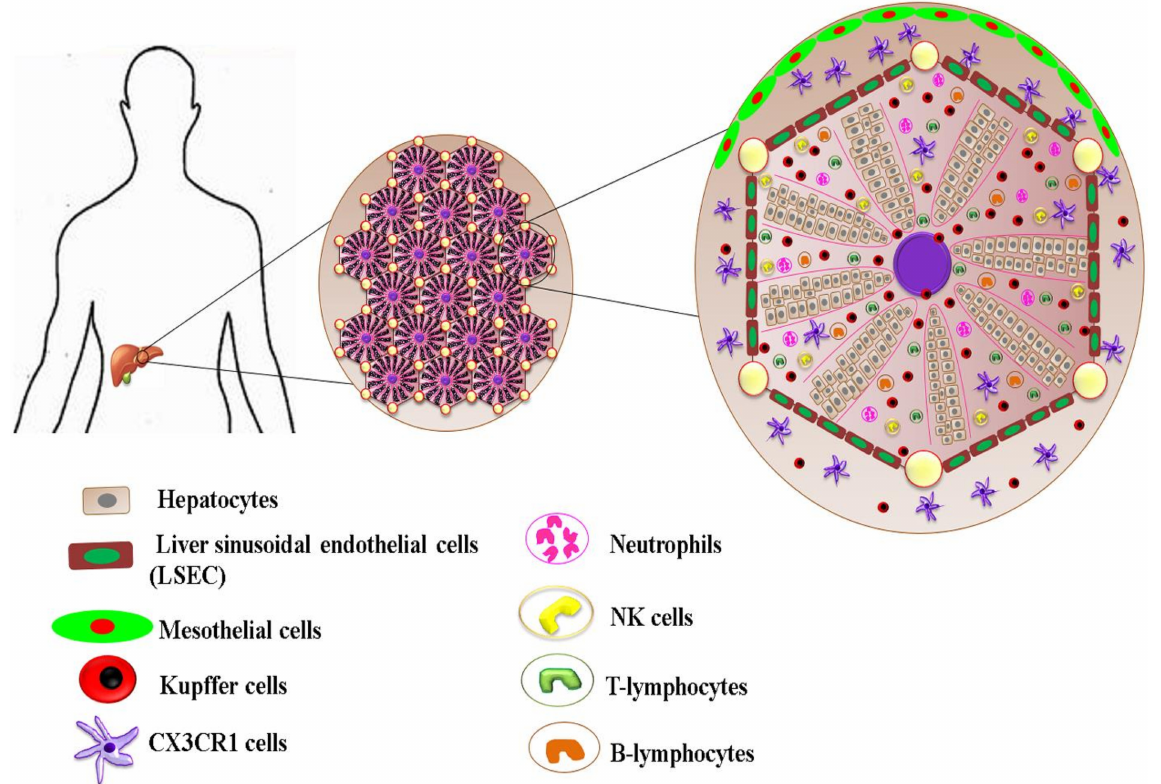
Figure 1. Anatomical organization and distribution of various immune cells in the liver. The sinusoidal endothelial cells of the liver in the sinusoidal lining directly interact with resident liver macrophages, KCs. The liver harbors varying proportions of lymphoid cells such as natural killer cells, natural killer T cells, γδ T cells, and liver transiting or resident T